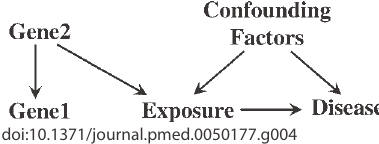
Figure 2. A Mendelian Randomisation Study Where the Chosen Instrument Is in Linkage Disequilibrium with a Variant Associated With, or Causal For, the Disease Note that the direction of the arrow depicting the statistical association between the two genes is interchangeable.